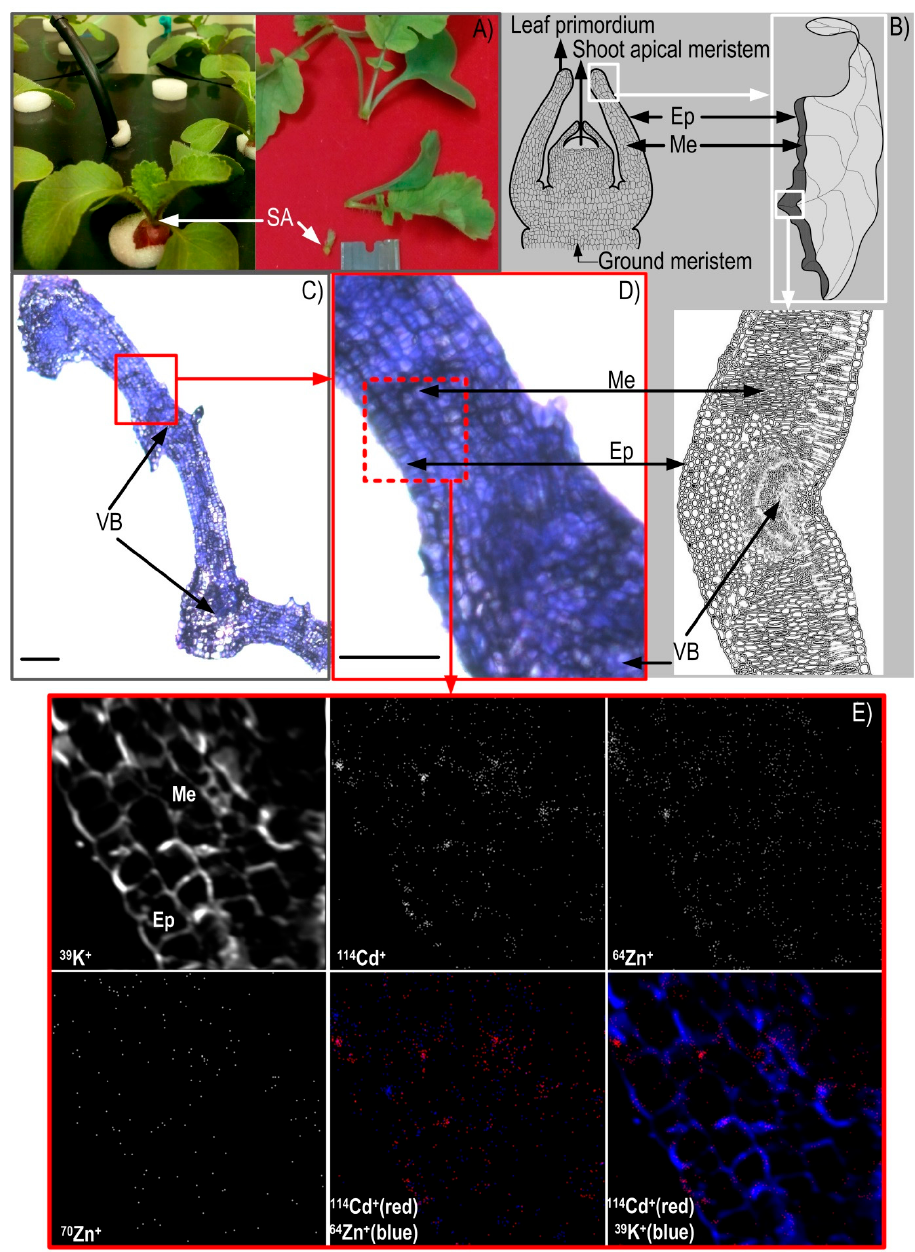
Figure 3. ( A ) Cultivated 18-day-old radish plants ( Raphanus sativus L. cv. Cherry Belle) after 24-h exposure to the equimolar (2.2 µ M ) Cd/ 70 Zn treatment and a shoot apex (SA) during sampling. ( B ) Schematic presentation of vertical section of the shoot apex (left) and details of leaf primordia (right, bottom) tissue. Ep, leaf epidermis; Me, leaf mesophyll, VB, vascular bundle. ( C , D ) Optical micrographs of the Araldite 502 resin-embedded transverse sections of radish leaf primordia exposed to the equimolar (2.2 µ M ) Cd/ 70 Zn treatment for 24 h and prepared by freezing in liquid N slush followed by freeze substitution and staining with toluidine blue. On the magnified area ( D ), the dotted square represents the region of interest scanned by the NanoSIMS. Bars represent 100 µ m ( C ) and 50 µ m ( D ). ( E ) The high-resolution secondary ion mass spectrometry (NanoSIMS) images (50 µ m × 50 µ m) obtained using the O − primary ion beam and processed by multi-isotope imaging mass spectrometry (MIMS) to indicate distribution of 39 K + , 64 Zn + , 70 Zn + and 114 Cd + as separate and composite (dual)